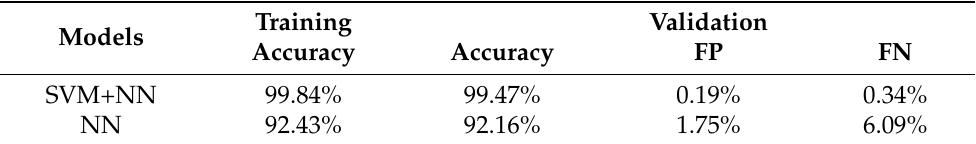
Table 2. Accuracy and false rates of restoring ground truth traces with or without the SVM (Type-I dataset).